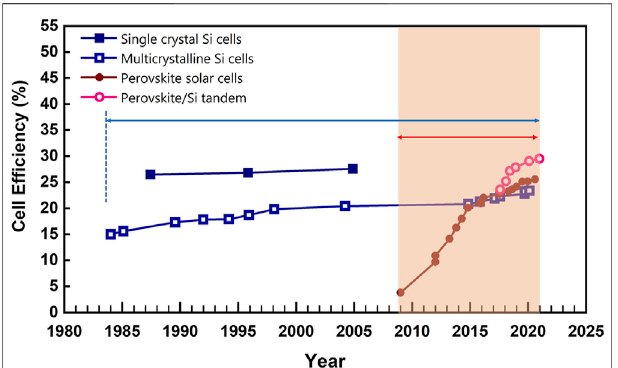
FIGURE1| Progressofcellef fi ciencyinsinglecrystalandmulticrystalline Si cells, perovskite solar cells, perovskite/Si tandem according to Best Research-Cell Ef fi ciency chart from National Renewable Energy Laboratory (NREL,